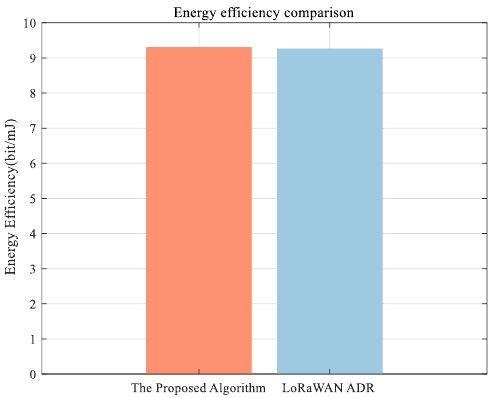
Figure 20. Energy efficiency comparison.